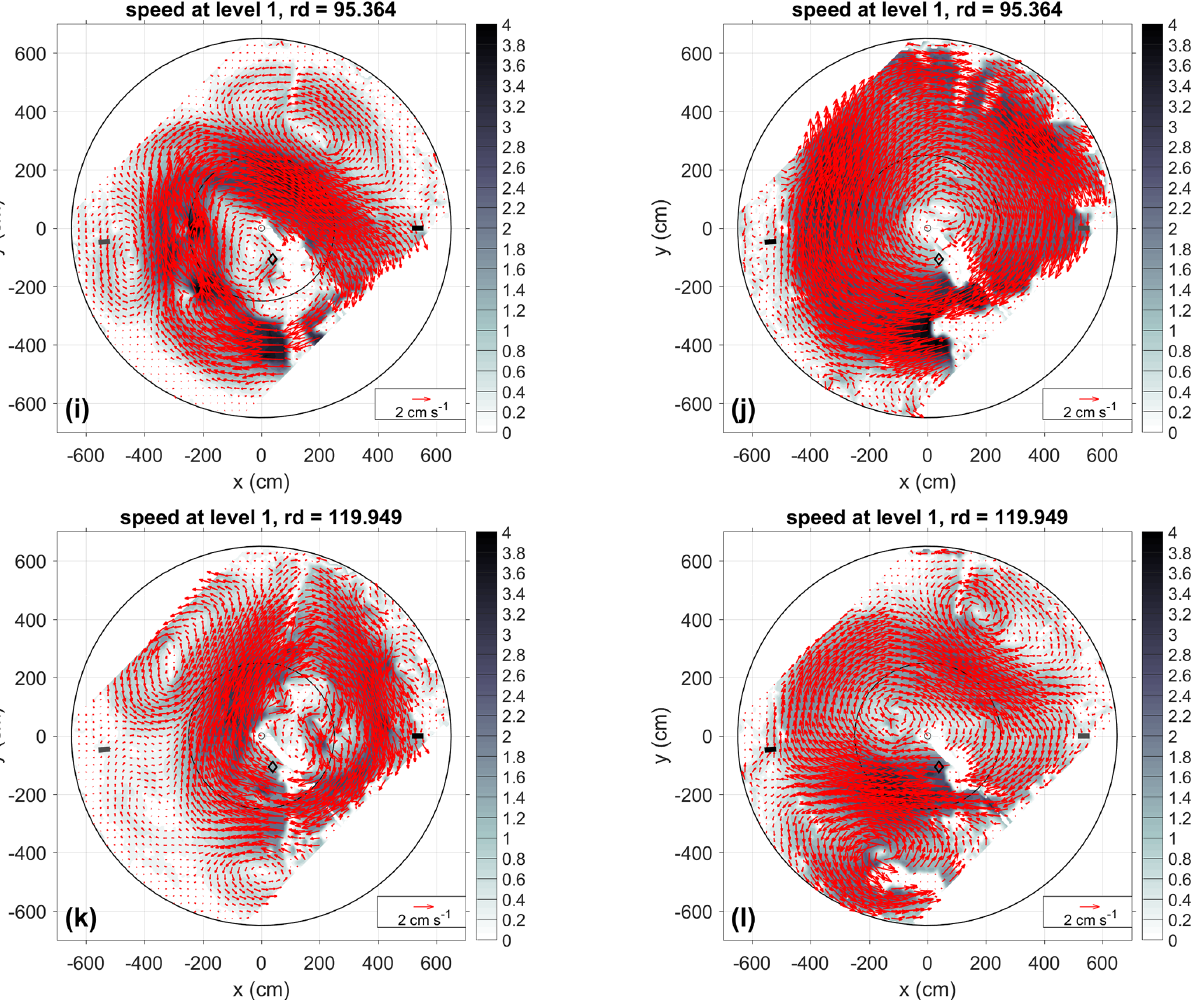
Figure 8. Two realizations of the current field at level 1 (surface) from each phase: Phase I, i.e., before the high-density water injection, rd<45 (a, b, c, d) ; Phase II, i.e., when the high-density water injection is switched on, 45<rd<90 (e, f, g, h) ; and Phase III, i.e., when the high-density water injection is switched off, rd>90 (i, j, k, l) . Panels (a), (c), (e), (g), (i) , and (k) show EXP 24, and panels (b), (d), (f), (h), (j) , and (l) show EXP 27. “rd” stands for rotation